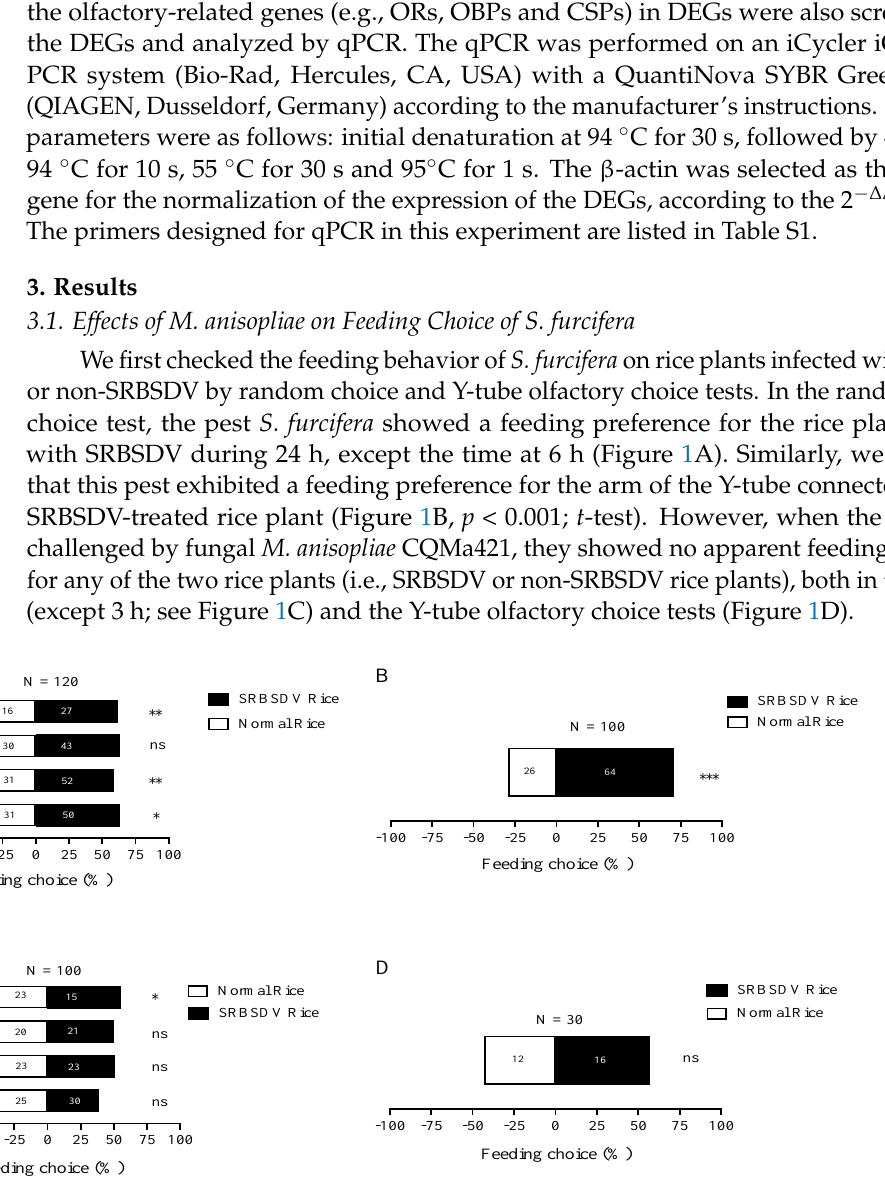
Figure 1. The effects of M. anisopliae on host S. furcifera feeding behavior. ( A ) Feeding choice of S. furcifera for SRBSDV or non-SRBSDV rice plants under random feeding test; ( B ) feeding choice of S. furcifera for SRBSDV or non-SRBSDV rice plants under Y-tube olfactory test; ( C ) after 48 h infection, the feeding choice of S. furcifera for SRBSDV or non-SRBSDV rice plants under random feeding test; ( D ) after 48 h infection, the feeding choice of S. furcifera for SRBSDV or non-SRBSDV rice plants under the Y-tube olfactory test. The asterisks indicate the significant difference. “*” indicates p < 0.05; “**” indicates p < 0.01 and “***” indicates p <